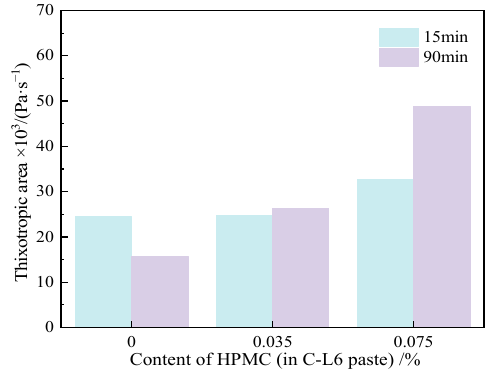
Figure 18. Thixotropic area of C-L6-HPMC pastes.